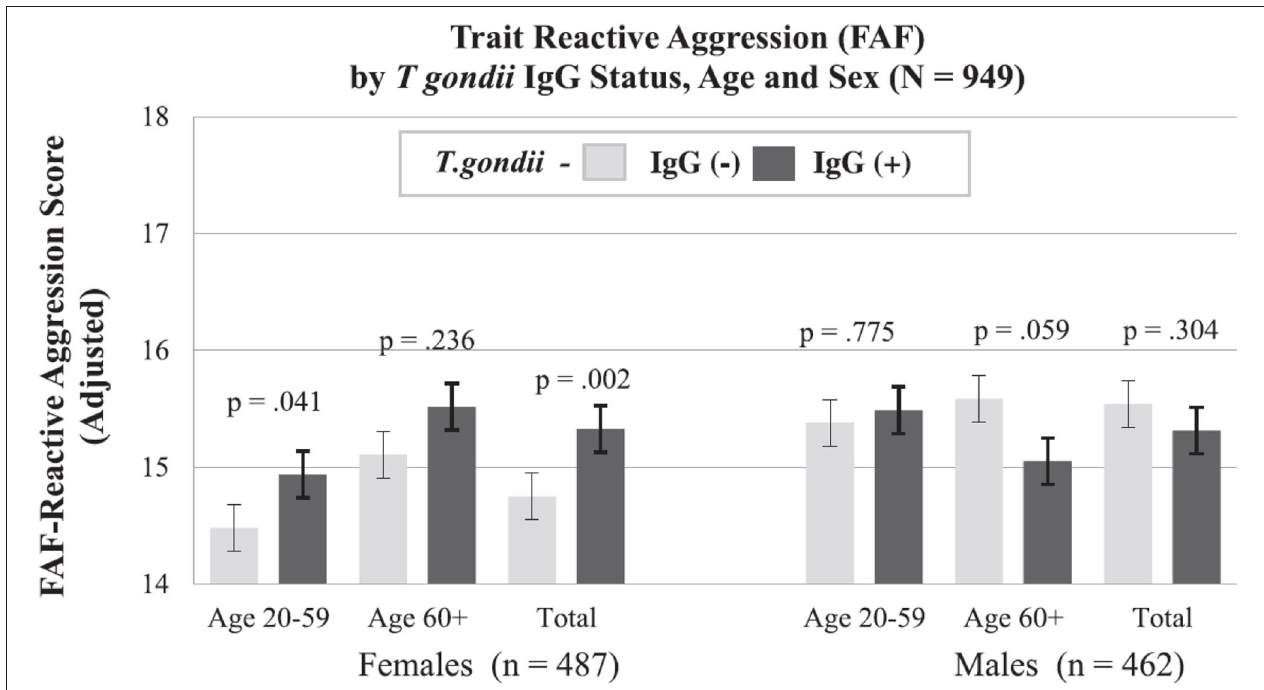
FIGURE 6 | Trait Reactive Aggression (FAF) by Age, Sex, and T. gondii IgG Status ( N = 949). Women, but not men, had a significant ( p < 0.01) association between T. gondii IgG seropositivity and higher trait reactive aggression scores (determined by the FAF-Fragebogen zur Erfassung von Aggressivitätsfaktoren). T. gondii IgG (–), T. gondii IgG seronegative, T. gondii IgG + , T. gondii IgG seropositive. The two age groups are separated by median age (60 years). The overall reactive aggression scores are higher in men, but T. gondii -positive women have a similar level of reactive aggression with men. [Reprinted with permission from (114); Copyright (2015); with permission from Elsevier; License #